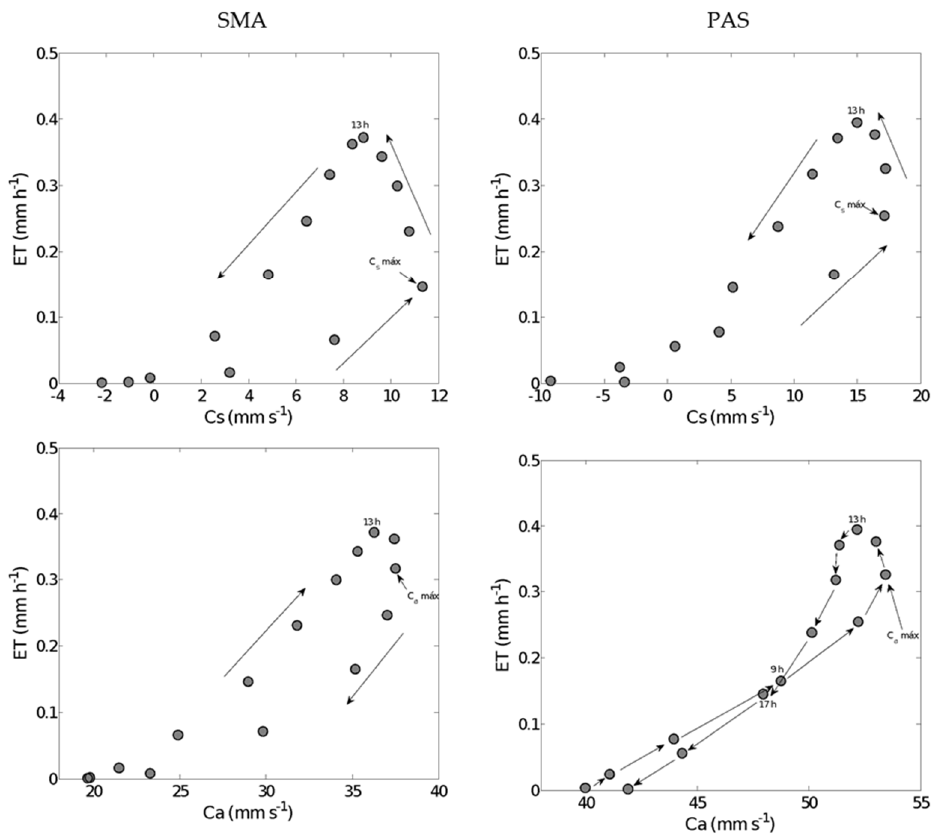
Figure 8. Hysteresis loops between surface conductance ( Cs , mm s − 1 ), aerodynamic conductance ( Ca , mm s − 1 ), and evapotranspiration ( ET , mm h − 1 ) for the SMA and PAS sites, from 1 September 2014 to